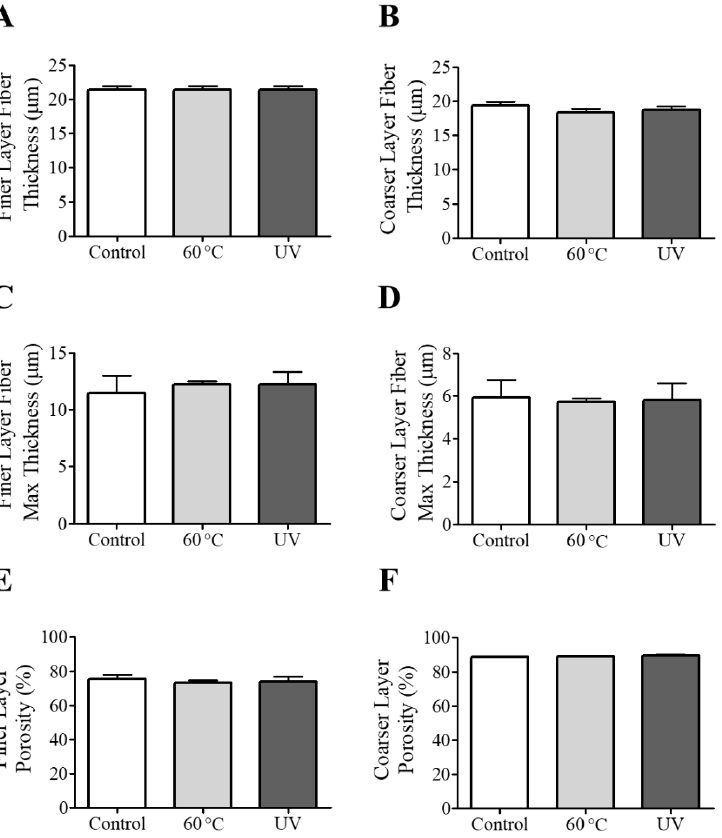
Figure 5. ( A , B ) The finer and coarser layer thickness, ( C , D ) max thickness and ( E , F ) po- rosity for different types of samples. Results are expressed as mean ± standard